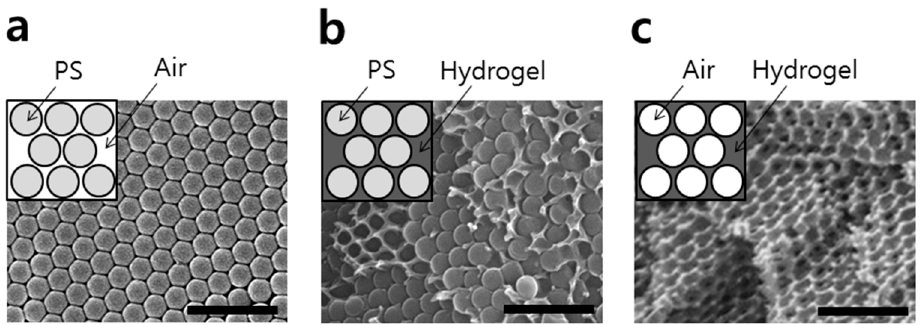
Figure 3. SEM images of a ( a ) PS opal template, ( b ) opal template with a cross-linked thermochromic gel, and ( c ) a thermochromic inverse opal gel after template removal. Scale bars in the images represent 1 µm.